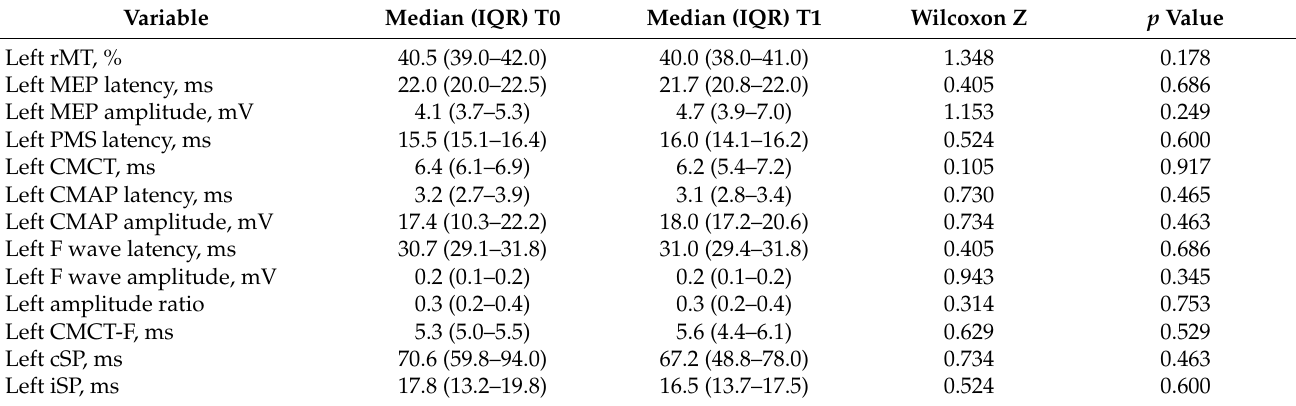
Table 3. Electrophysiological data to TMS of all participants at baseline (T0) and at follow-up